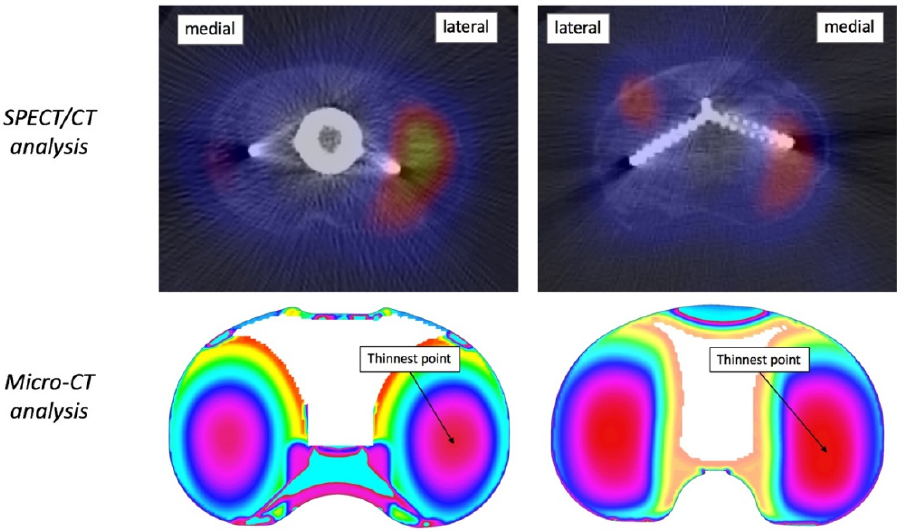
Figure 6. Examples of correlation between SPECT/CT and micro-CT data. ( Left ) left knee showing a more extended BTU on the lateral side, which correlates with a thinner lateral compartment; ( Right ) right knee showing a more extended BTU on the medial side, which correlates with a thinner medial compartment.